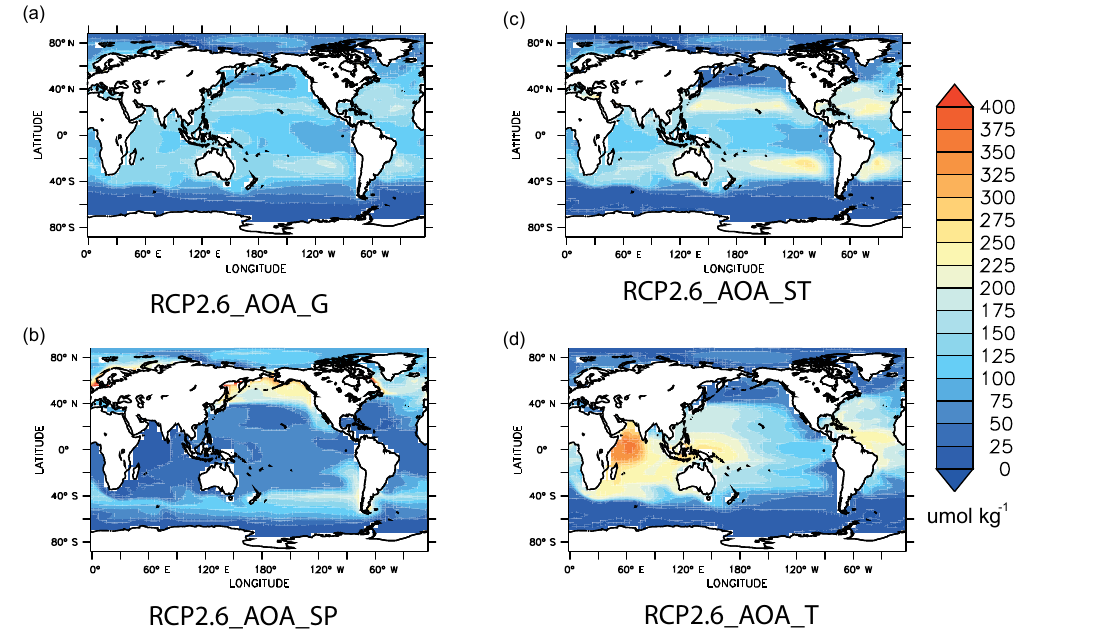
Figure 3. The spatial map of the increase in surface alkalinity in 2090 (mean; 2081–2100) associated with global and regional AOA under RCP2.6 relative to RCP2.6 with no AOA. Units are µmolkg − 1 .